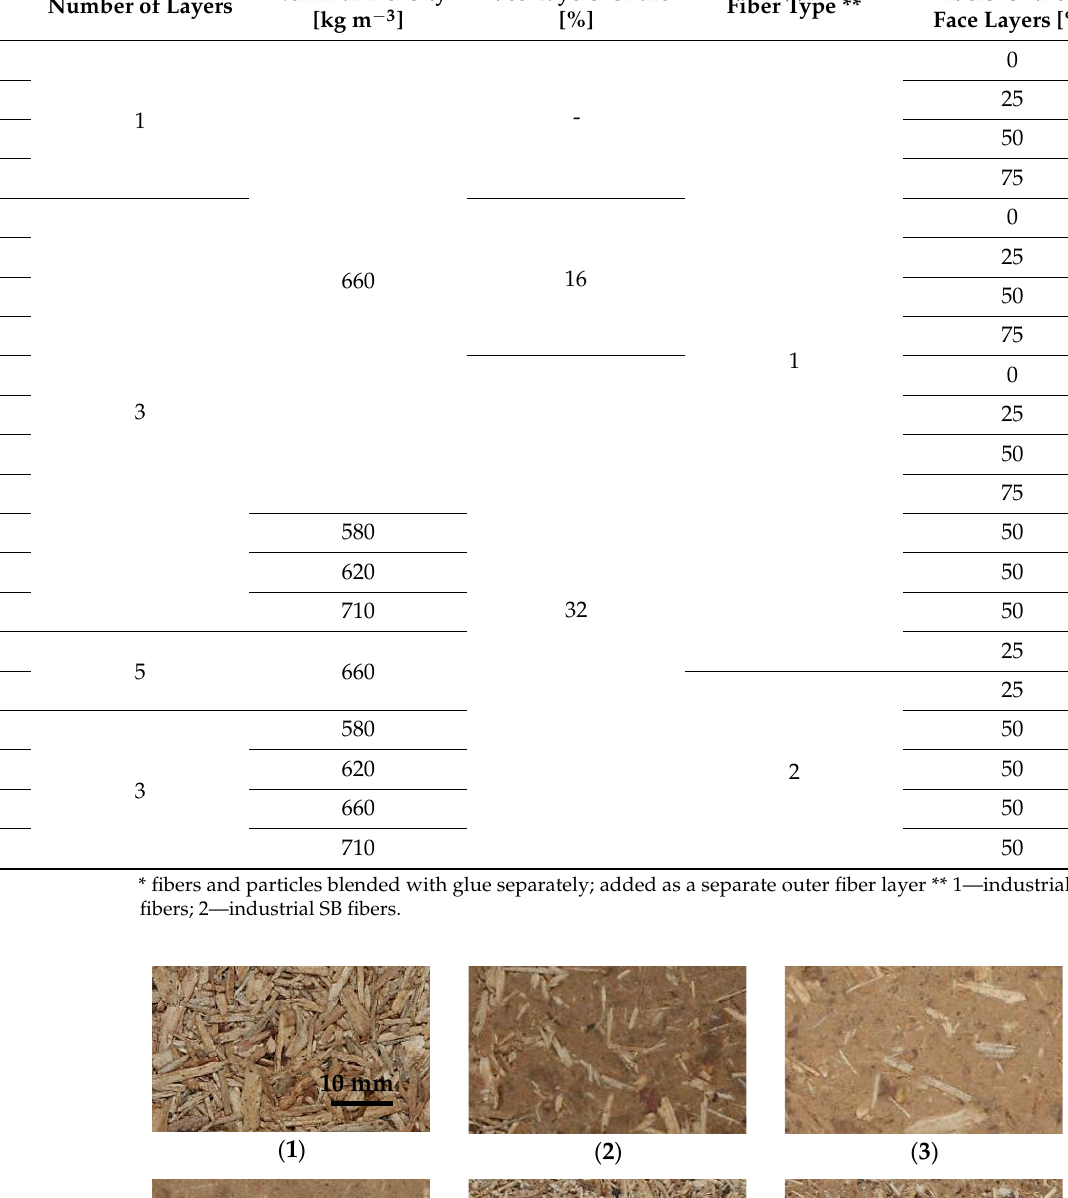
Table 1. Types of tested panels.